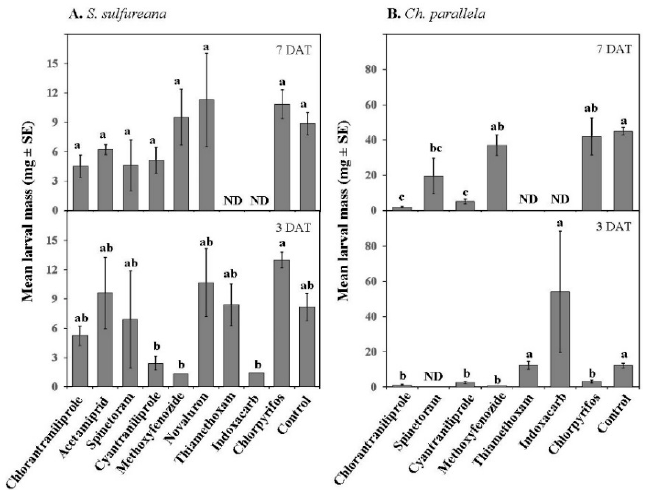
Figure 8. Effect of various insecticides on Sparganothis sulfureana ( A ) and Choristoneura parallela ( B ) 3rd instar larval mass after exposure to 3 and 7 DAT field-aged residues. DAT = days after treatment. ND = not determined. Bars with the same letter are not significantly different at α = 0.05.